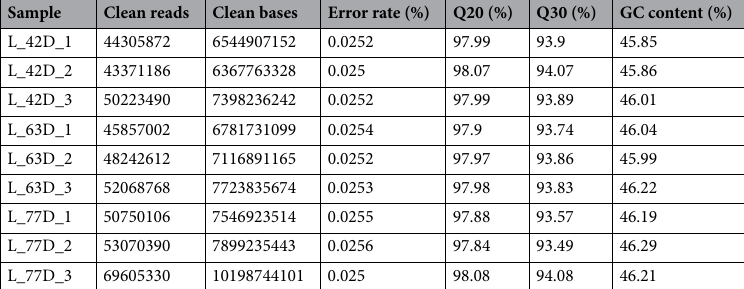
Table 1. Statistics on the quality and output of the RNA-Seq